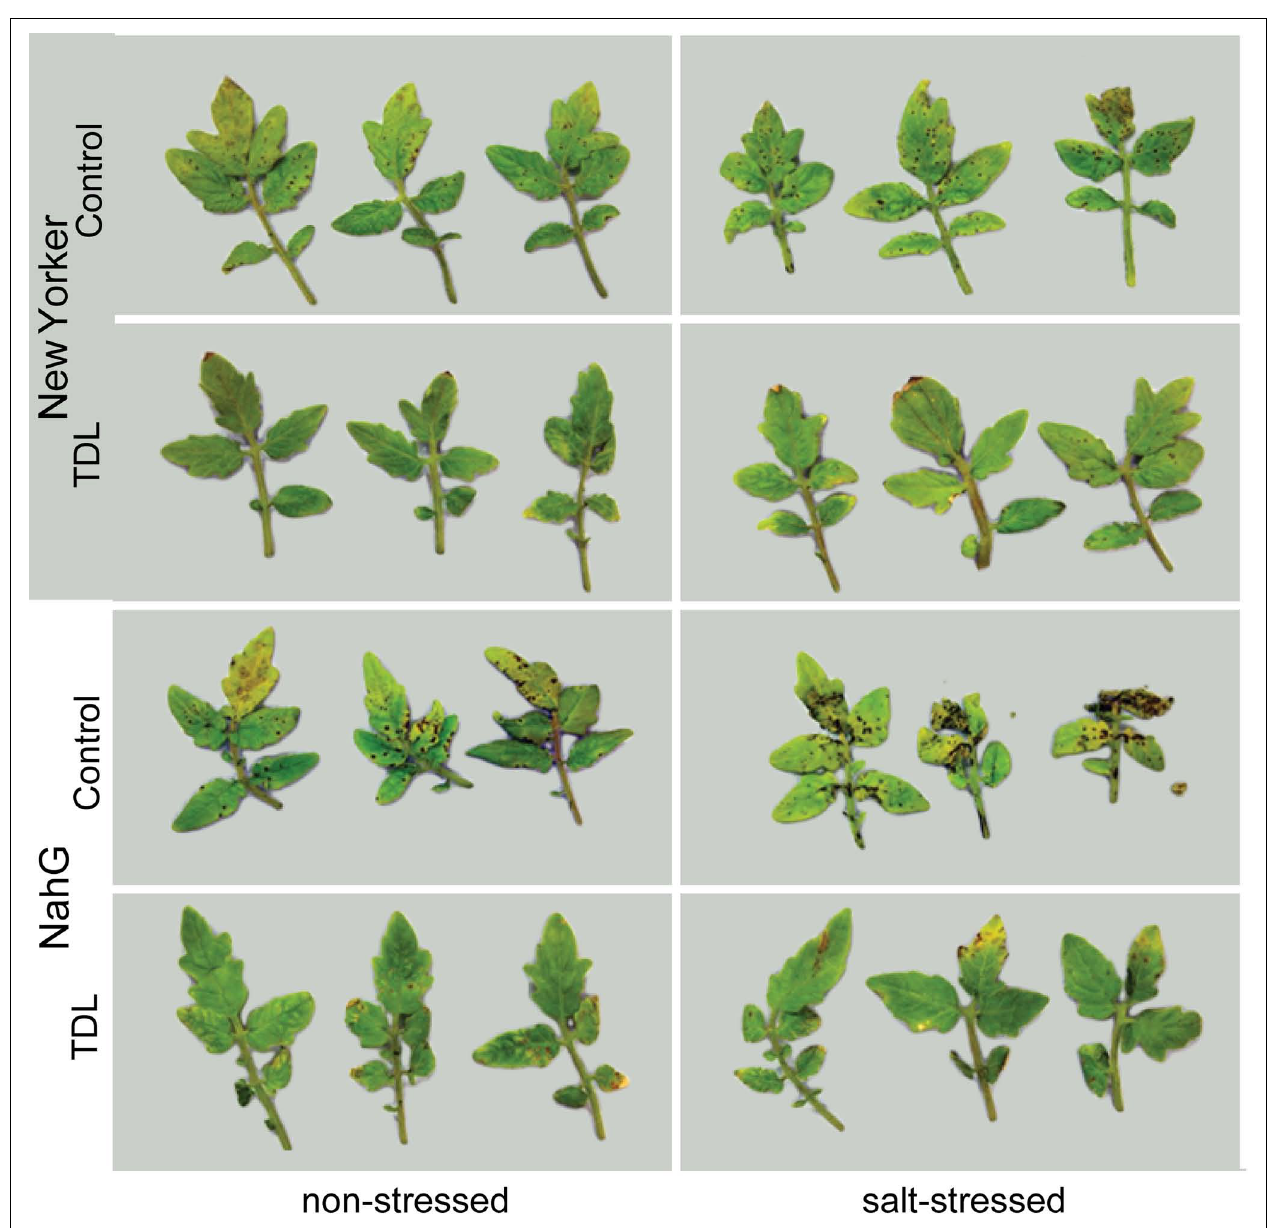
FIGURE 1 | Pseudomonas syringae pv. tomato colonization inWT background (“NewYorker”) and NahG tomato leaves. Roots were pretreated with TDL for 7 days and then exposed for 18 h to salt stress (0.2 M NaCl/0.02 M CaCl 2 ). Shoots were dip-inoculated with a suspension of Pst adjusted to 10 7 cfu ml − 1 . Symptoms photographed 4